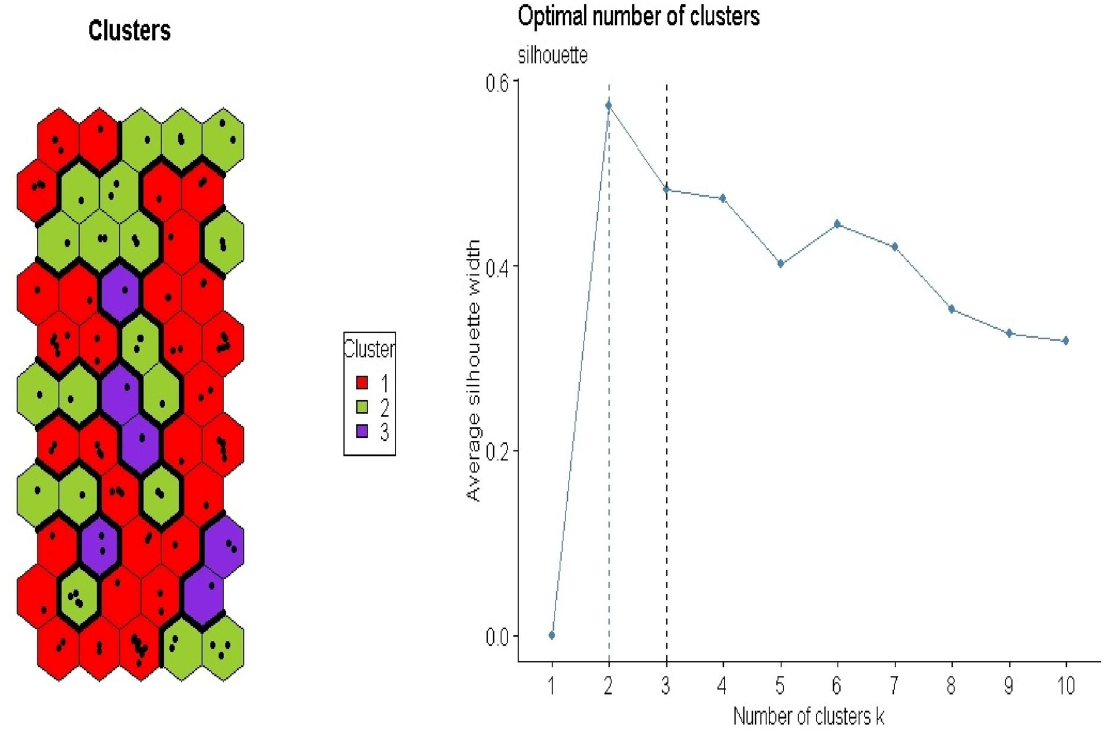
Figure 7. Different clusters classification components [The SeOM map was created with RStudio (Version 1.4.1717: https:// www. rstud io.